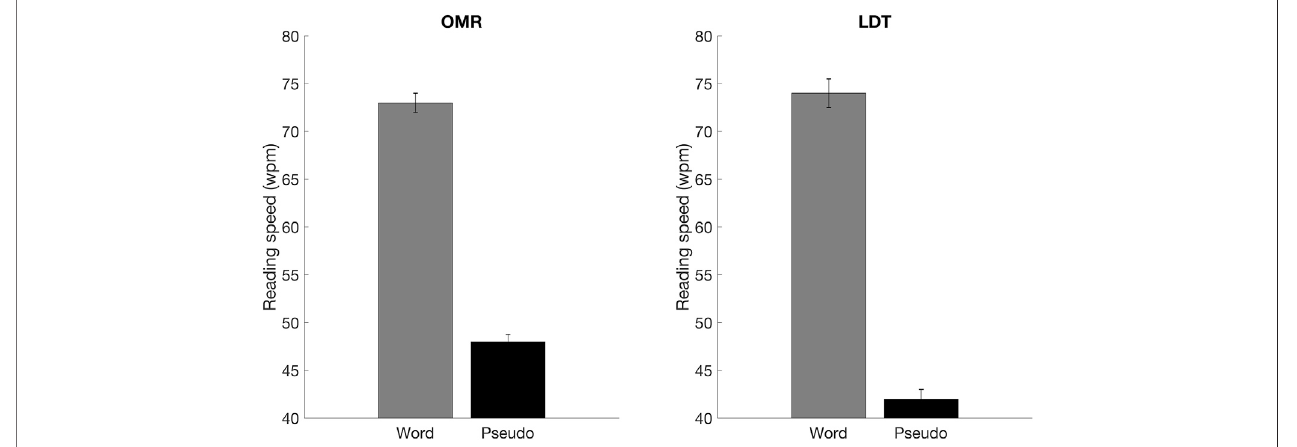
FIGURE1| Meancorrectword/pseudowordperminutefortheOne-MinuteReadingtest(OMR;left)andreadingspeedintheLexicalDecisionTask(LDT;right)for words and pseudowords. Error bars represent 95% CIs.